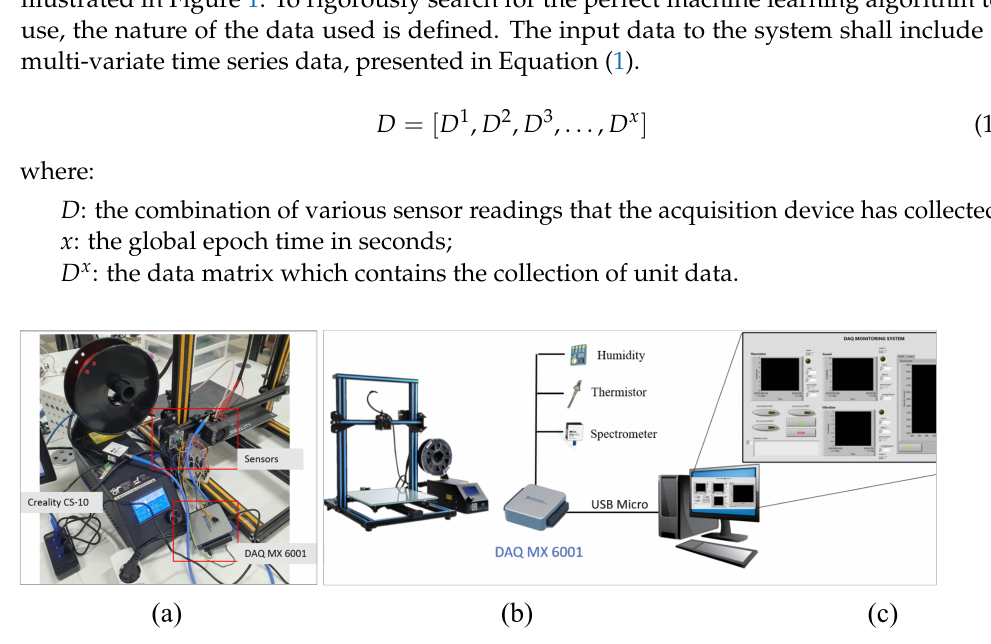
Figure 1. ( a ) The actual experimental setup for the data acquisition using the FDM 3D Printer Creality CS-10, and the data acquisition device, DAQ MX 6001. ( b ) The architecture of the experimental setup featuring the sensors that were gathered to be processed in the proposed MH-ED-TCN scheme. ( c ) The developed monitoring system software graphical